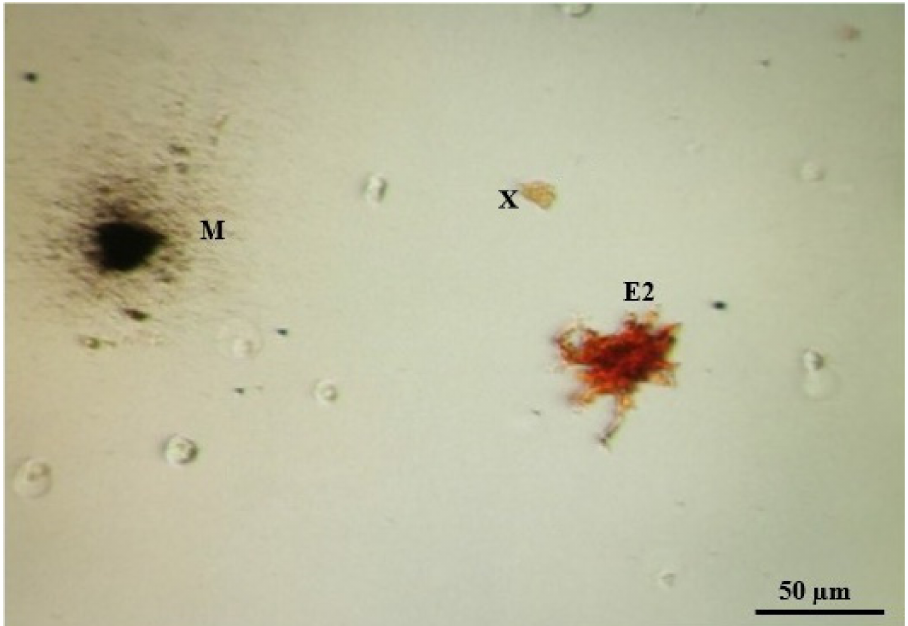
Figure 3. Single-cell suspension from a biopsy cut-out of a brown trout red-spotted skin region after 80 min of enzyme digestion in collagenase solution (1 mg/mL) and washing with PBS buffer. The melanophore has burst due to the long incubation time. M—melanophores, X—xanthophores, E2—subtype 2